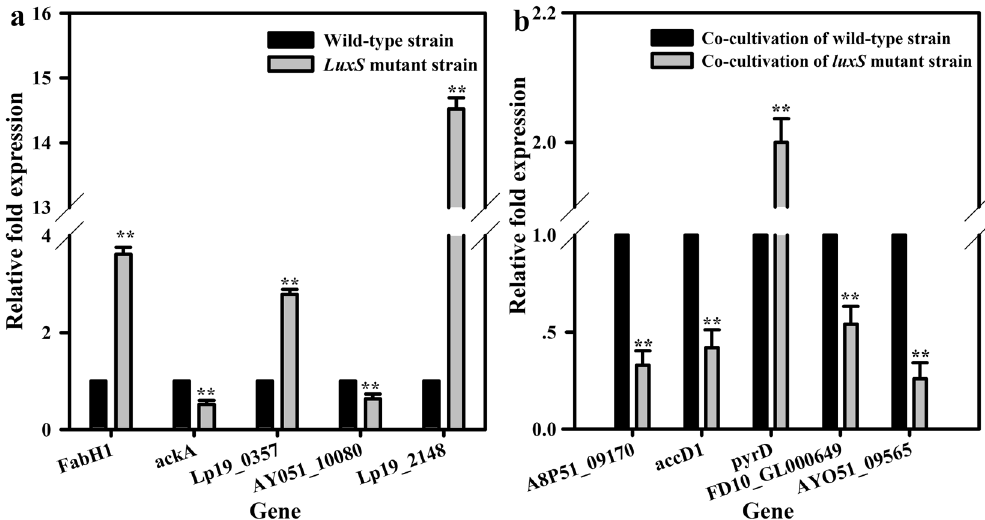
Figure 5. Quantitative real-time reverse transcription PCR (qRT-PCR) analysis of gene expression of altered proteins in mono-cultivation of L. plantarum KLDS1.0391 [( a ) including five altered proteins] and co- cultivation of L. plantarum KLDS1.0391 with L. helveticus KLDS1.9207 [( b ) including five altered proteins] upon luxS knockout. ** Statistically significant difference between L. plantarum KLDS1.0391 wild-type strain and luxS mutant strain ( P <